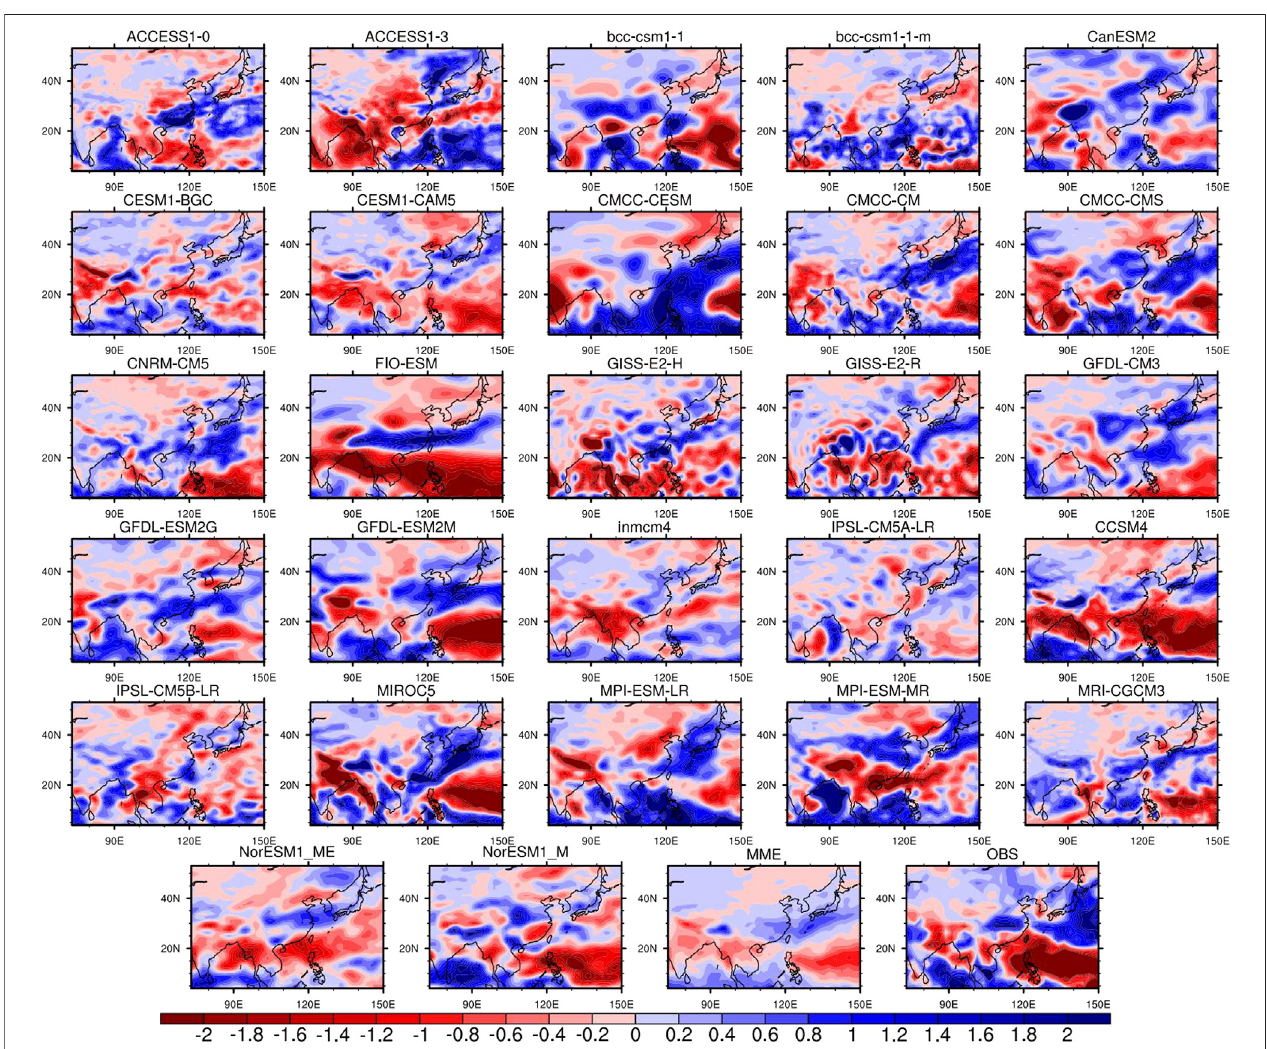
FIGURE 1 | The distributions of precipitation anomaly (mm/day) during strong EP events in the following summer over East Asia for the historical experiments in CMIP5 models, their MME and corresponding observation.